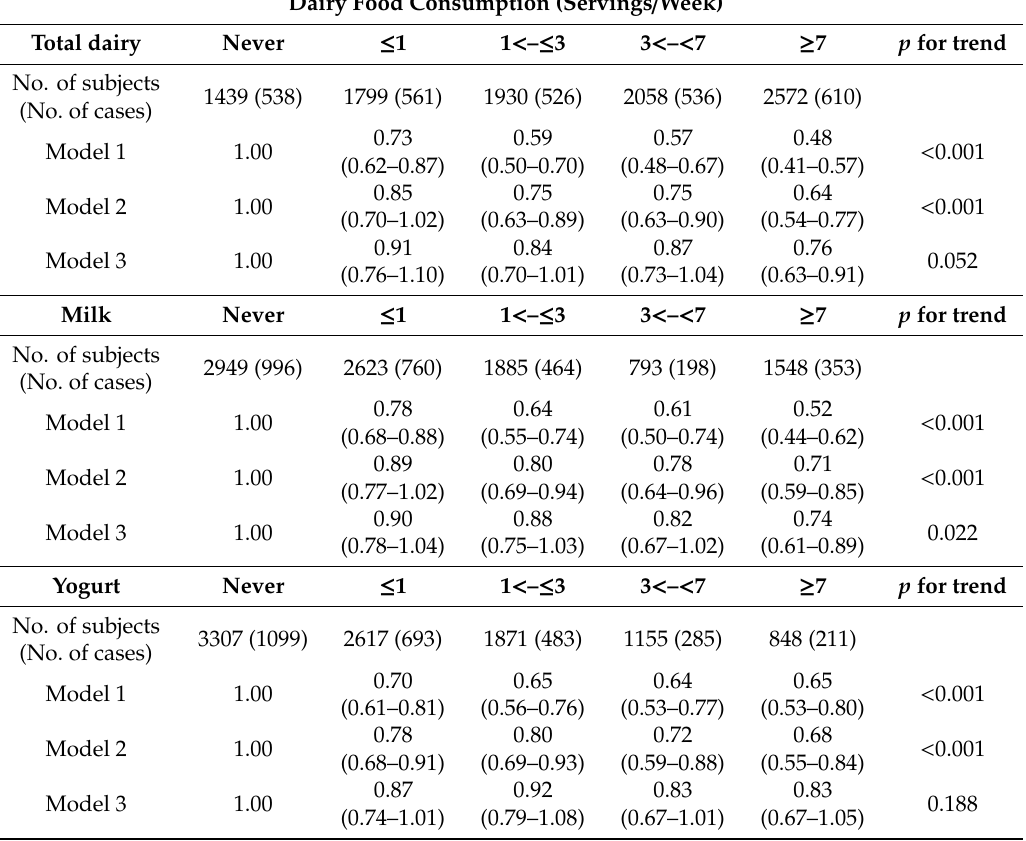
Table 4. Odds ratios (ORs) and 95% confidence intervals (CIs) for the risk of periodontal disease according to dairy food consumption 1